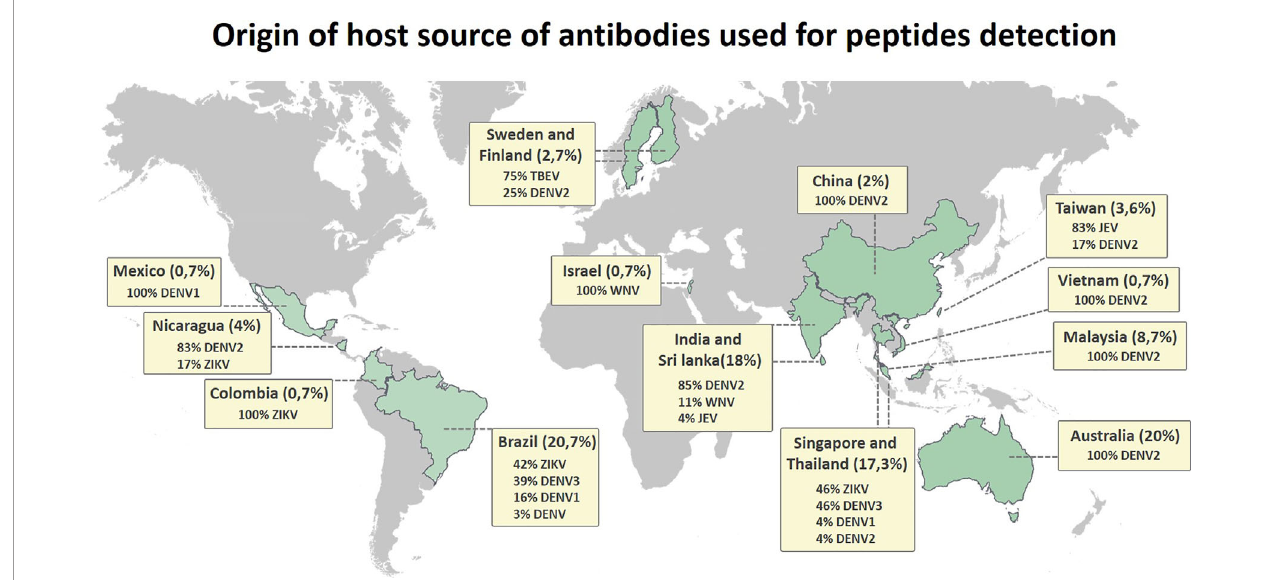
FIGURE 6 | Distribution map showing the origin of the host source of antibodies used for detection of Flavivirus linear immunoreactive peptides, indicating the host region of origin and grouping the percentage of discovered peptides by